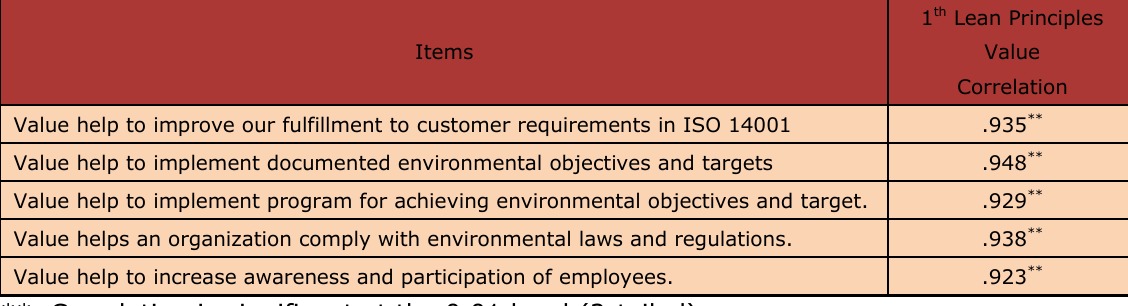
Table 6. Value with ISO 14001 Requirements